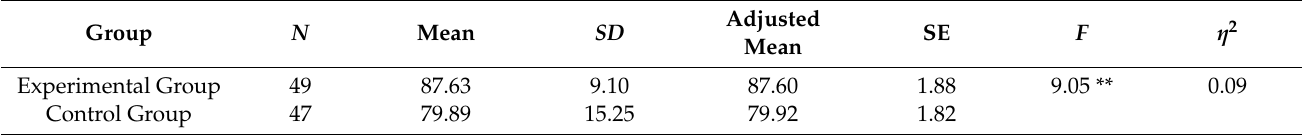
Table 1. The ANCOVA results of students’ learning achievements.